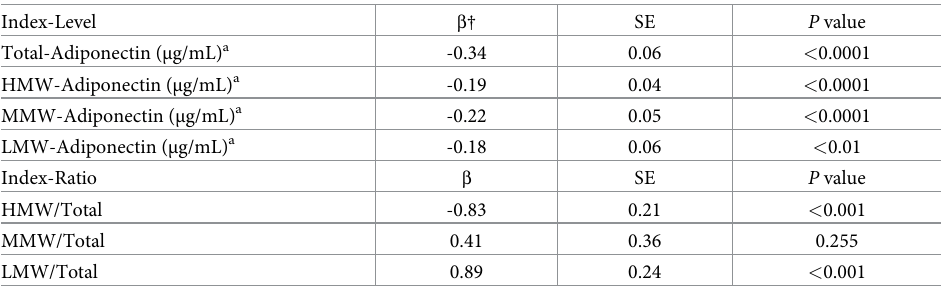
Table 6. Association of adiponectin-related parameters with HOMA-IR in the 2 nd